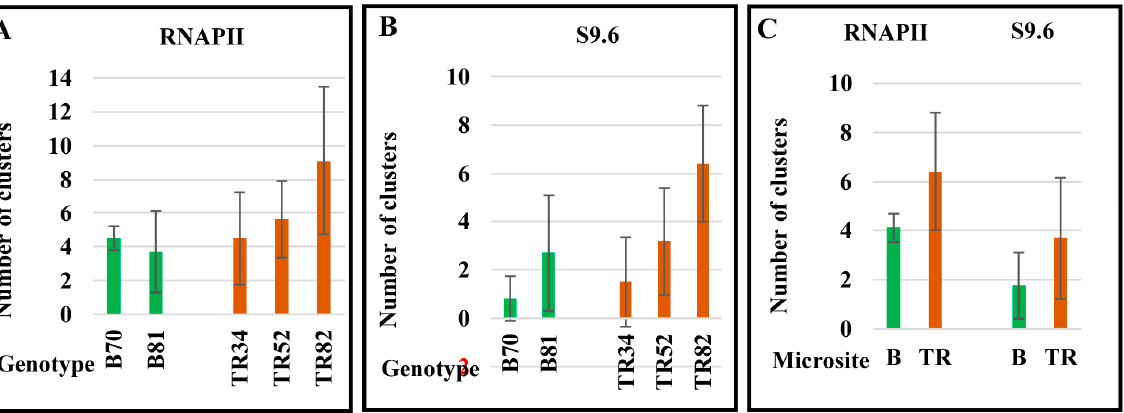
Figure 6. Number of clusters of RNAPII ( A ) and S9.6 ( B ) on metaphase chromosomes in individual plants of the Basalt (B) and the Terra Rossa (TR) microsites in the Tabigha population. ( C ) The mean numbers of clusters are represented for B and TR microsites. Standard error bars are shown.